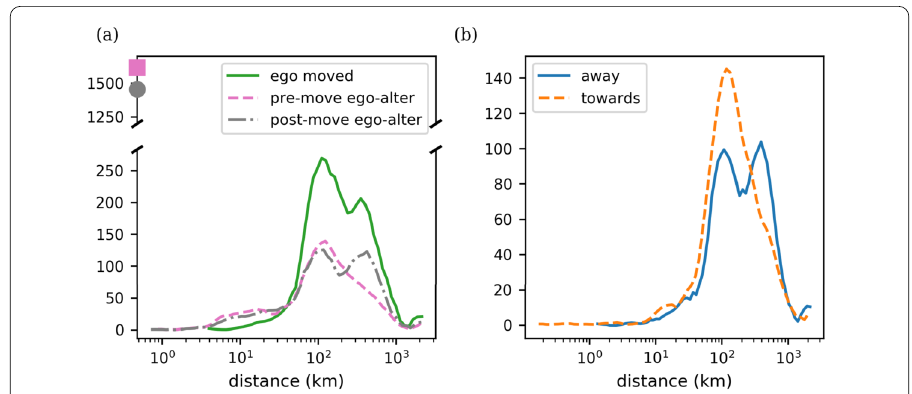
Figure 2 Distances relevant to the migration. The distributions of the distance moved by the ego ( ego moved ) and the pre- and post-move distances between the ego and the alter ( pre-move ego-alter and post-move ego-alter ) are superimposed in the left panel ( a ), with the filled square and the filled circle in the upper left corner indicating the number of pairs where the pre- and post-move distances between the ego and alter, respectively, are zero. The right panel ( b ) shows the distributions of the absolute difference of the distance between the ego and the alter before and after moving, with separate curves for egos moving away from the alter and egos moving towards the alter. All curves were obtained by using the Savitsky-Golay filter on the raw